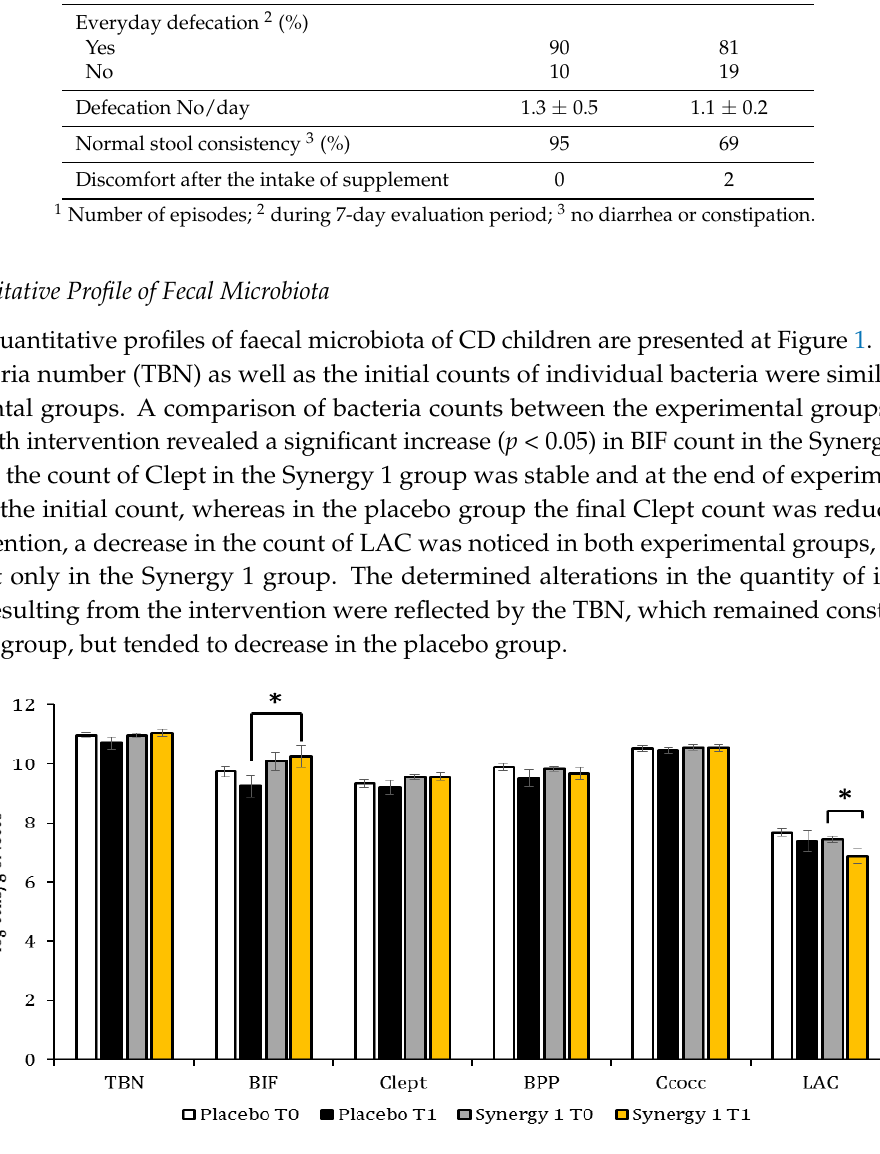
Table 2. Last-week survey observation.